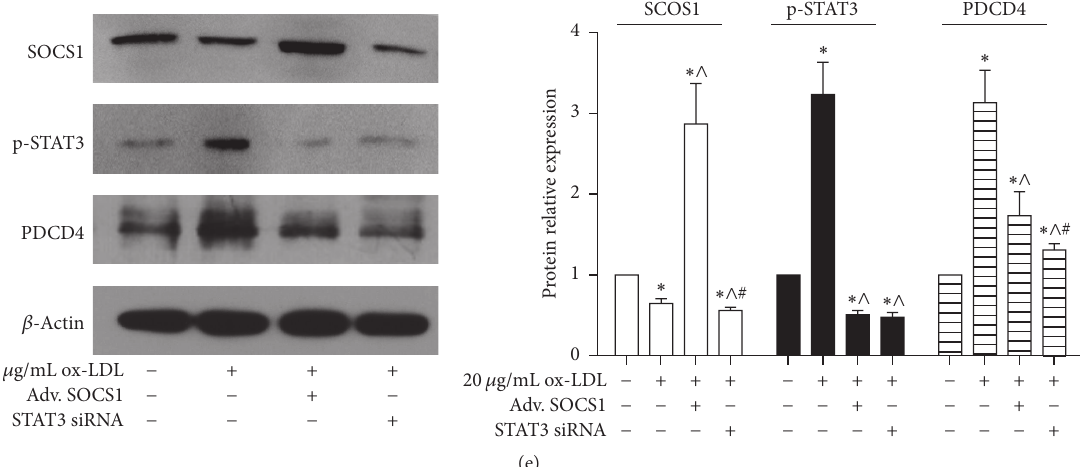
Figure 6: SOCS1-STAT3 pathway regulated PDCD4. (a) Fluorescence images ( × 100) showed RAW264.7 cells were infected with SOCS1 overexpression adenovirus (Adv. SOCS1) and vector adenovirus (Adv. GFP). (b) qPCR detected the SOCS1 mRNA expression after cells were infected with Adv. SOCS1 and Adv. GFP for 48 h: ∗ 𝑝 < 0.05 versus control, ∧ 𝑝 < 0.05 versus Adv. GFP group. (c) Downregulation of the expression of STAT3 mRNA by STAT3 siRNA in macrophages RAW264.7 cells. The relative expression of STAT3 mRNA was detected by qPCR after 50pM STAT3 siRNA, including si-01, si-02, and si-03, and negative control (NC) was transfected into RAW264.7 cells for 48 h, respectively: ∗ 𝑝 < 0.05 versus control, ∧ 𝑝 < 0.05 versus NC group. (d) Western blot analyzed the protein level of phospho-STAT3 (p-STAT3) when RAW264.7 cells had been treated by 50pM STAT3 siRNA (si-03) and NC for 48 h. Representative bands show the protein expression of STAT3 (the upper bands), 𝛽 -actin (the lower bands) in left panel, and the histograms in right panel showing quantification of STAT3 bands’ normalization relative to 𝛽 -actin expression in (d). ∗ 𝑝 < 0.05 versus NC group. (e) Western blot analyzed the protein level of SOCS1, p-STAT3, and PDCD4 in RAW264.7 cells. They were transfected into the Adv. SOCS1 or STAT3 siRNA for 24h and then treated by ox-LDL for 24 h. Representative bands show the protein expression of SOCS1 (the upper bands), p-STAT3 (the middle bands), PDCD4 (the third bands), and 𝛽 -actin (the lower bands) in left panel, and the histograms in right panel showing quantification of STAT3 bands’ normalization relative to 𝛽 -actin expression. ∗ 𝑝 < 0.05 versus control, ∧ 𝑝 < 0.05 versus 20 𝜇 g/mL ox-LDL group, and # 𝑝 < 0.05 versus 20 𝜇 g/mL ox-LDL plus Adv. SOCS1 group. The data are presented as the mean ± SE of three separate